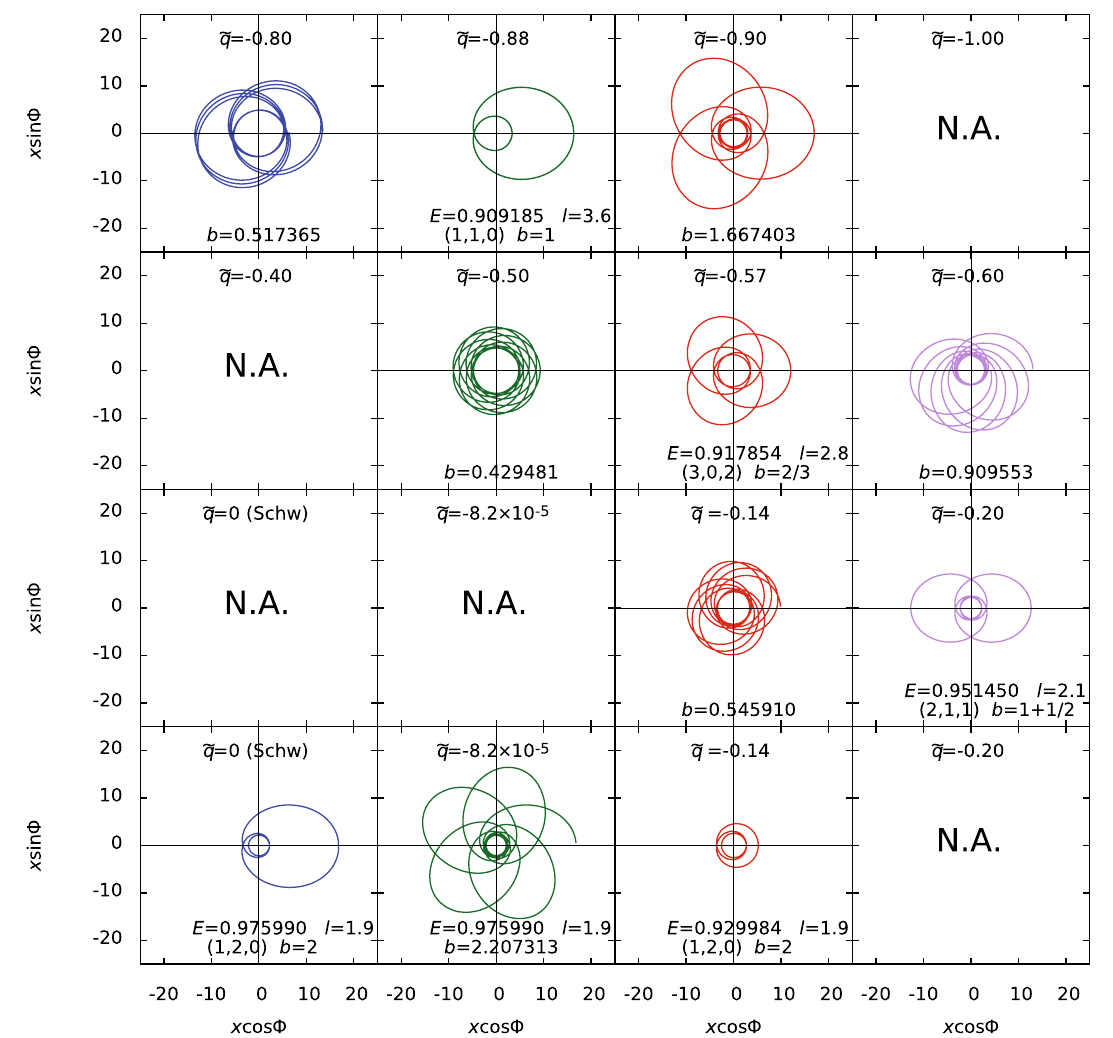
Fig. 8 The quasi-periodic and periodic orbits of a neutral timelike particle around the hairy black hole with the same l and E at each row for different values of ˜ q . “N.A” means that there is no bound orbit in specified E and l . “Schw” denotes the Schwarzschild